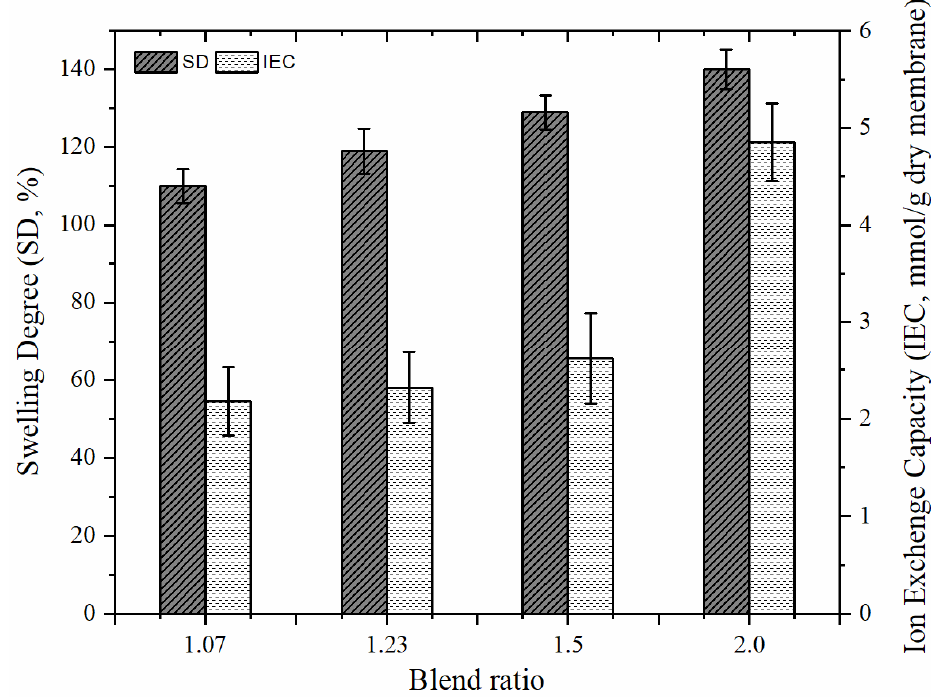
Figure 8. The effect of blend ratio on SD and IEC of synthesized AEMs (ER:1.62).